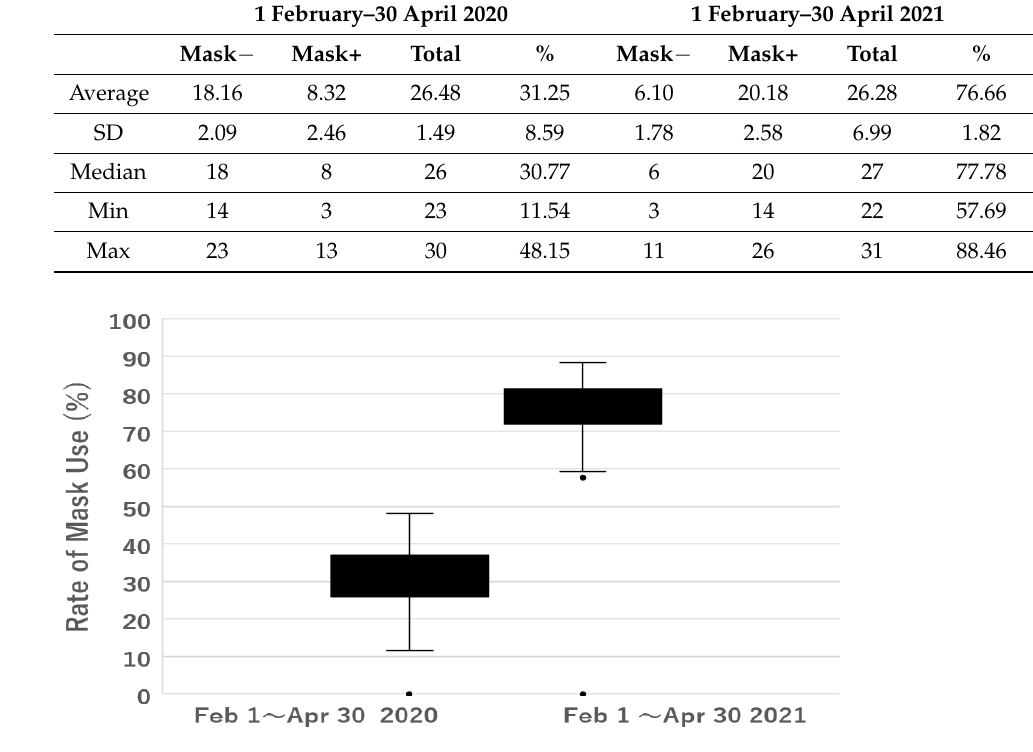
Figure 1. Rate of mask use. Table 1. Participant mask use in 2020 and 2021.